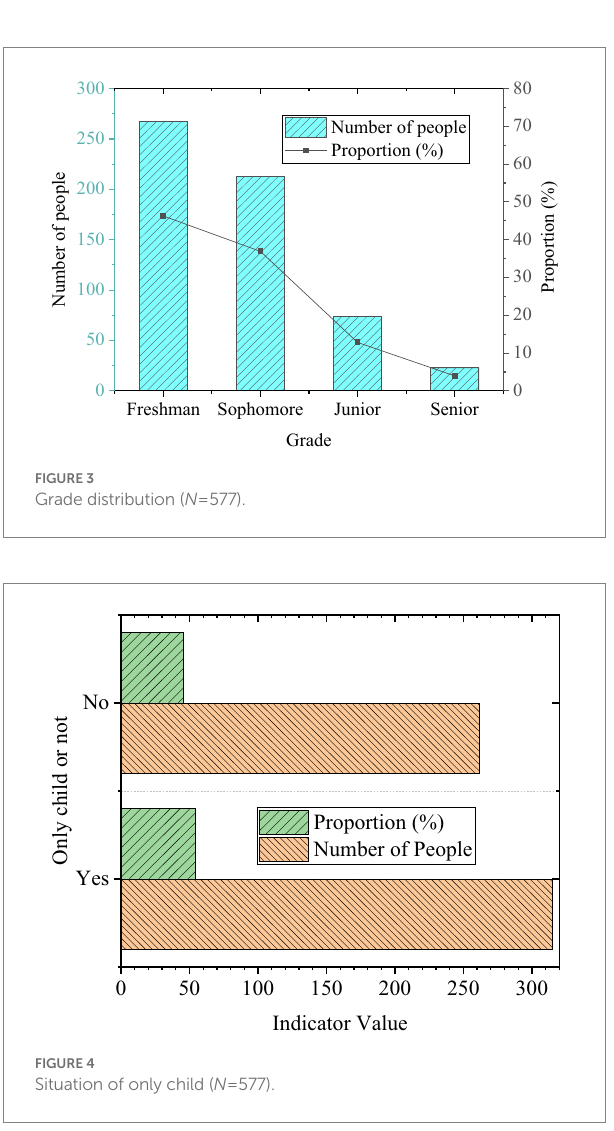
Figure 6 signifies that the anxiety score of college students ranges from 0 to 4, that is, 57.71% have no anxiety symptoms. The ratio of